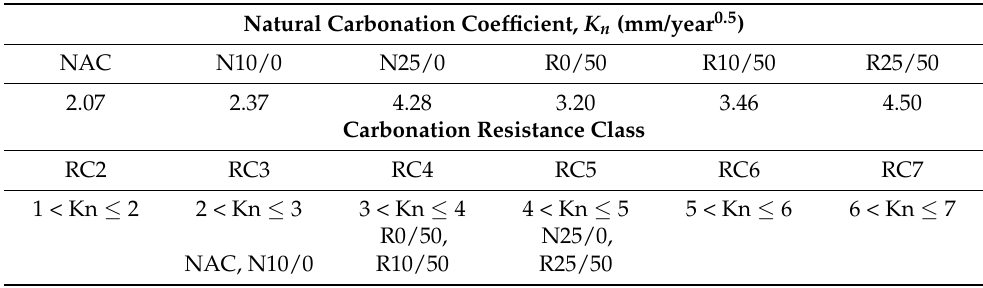
Table 8. Natural carbonation coefficients and carbonation resistance classes.